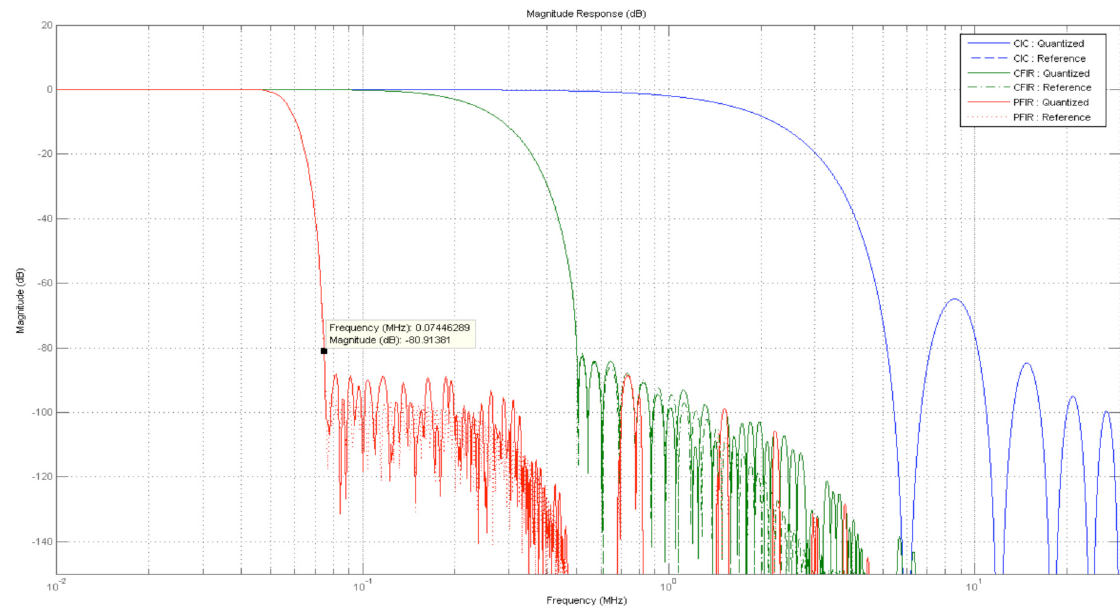
Figure 5. Frequency response of the CIC, CFIR and PFIR filters.